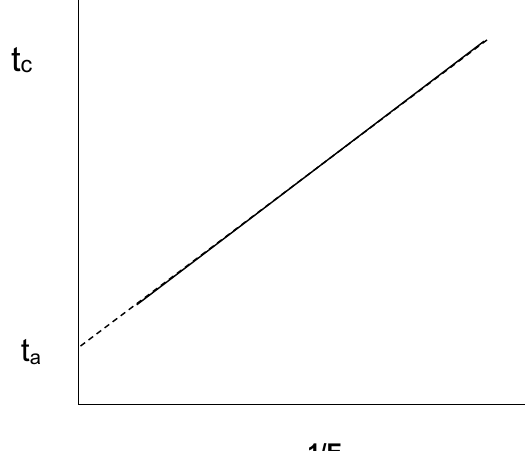
Figure 5. Relationship between enzyme concentration (E), aggregation time (t a ), and coagulation time (t c ). Reproduced with permission from [Dalgleish, D.G.], [A New Calculation of the Kinetics of the Renneting Reaction.]; published by [ J. Dairy Res. ], [1988]